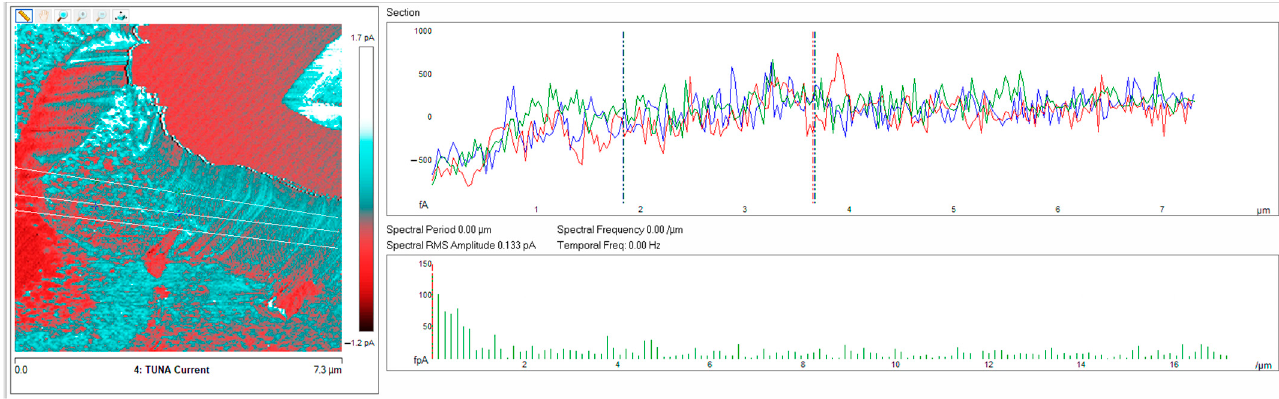
Figure 15. From left to right, TUNA Current picture and current variation profile of the sample TCTBD+0.5%MWCNT.